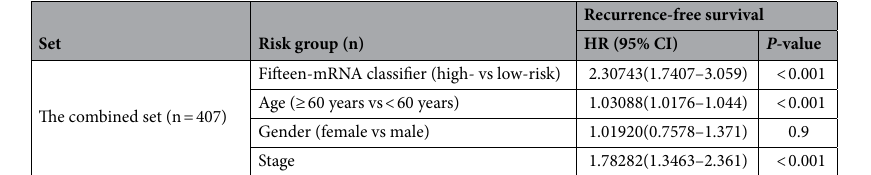
Table 6. Predictive value of the fifteen-mRNA signature, sex, age, stage, and survival in the combined set (n = 407, GSE30219 and GSE31210) analysed by multivariate Cox regression. The results showed a significant